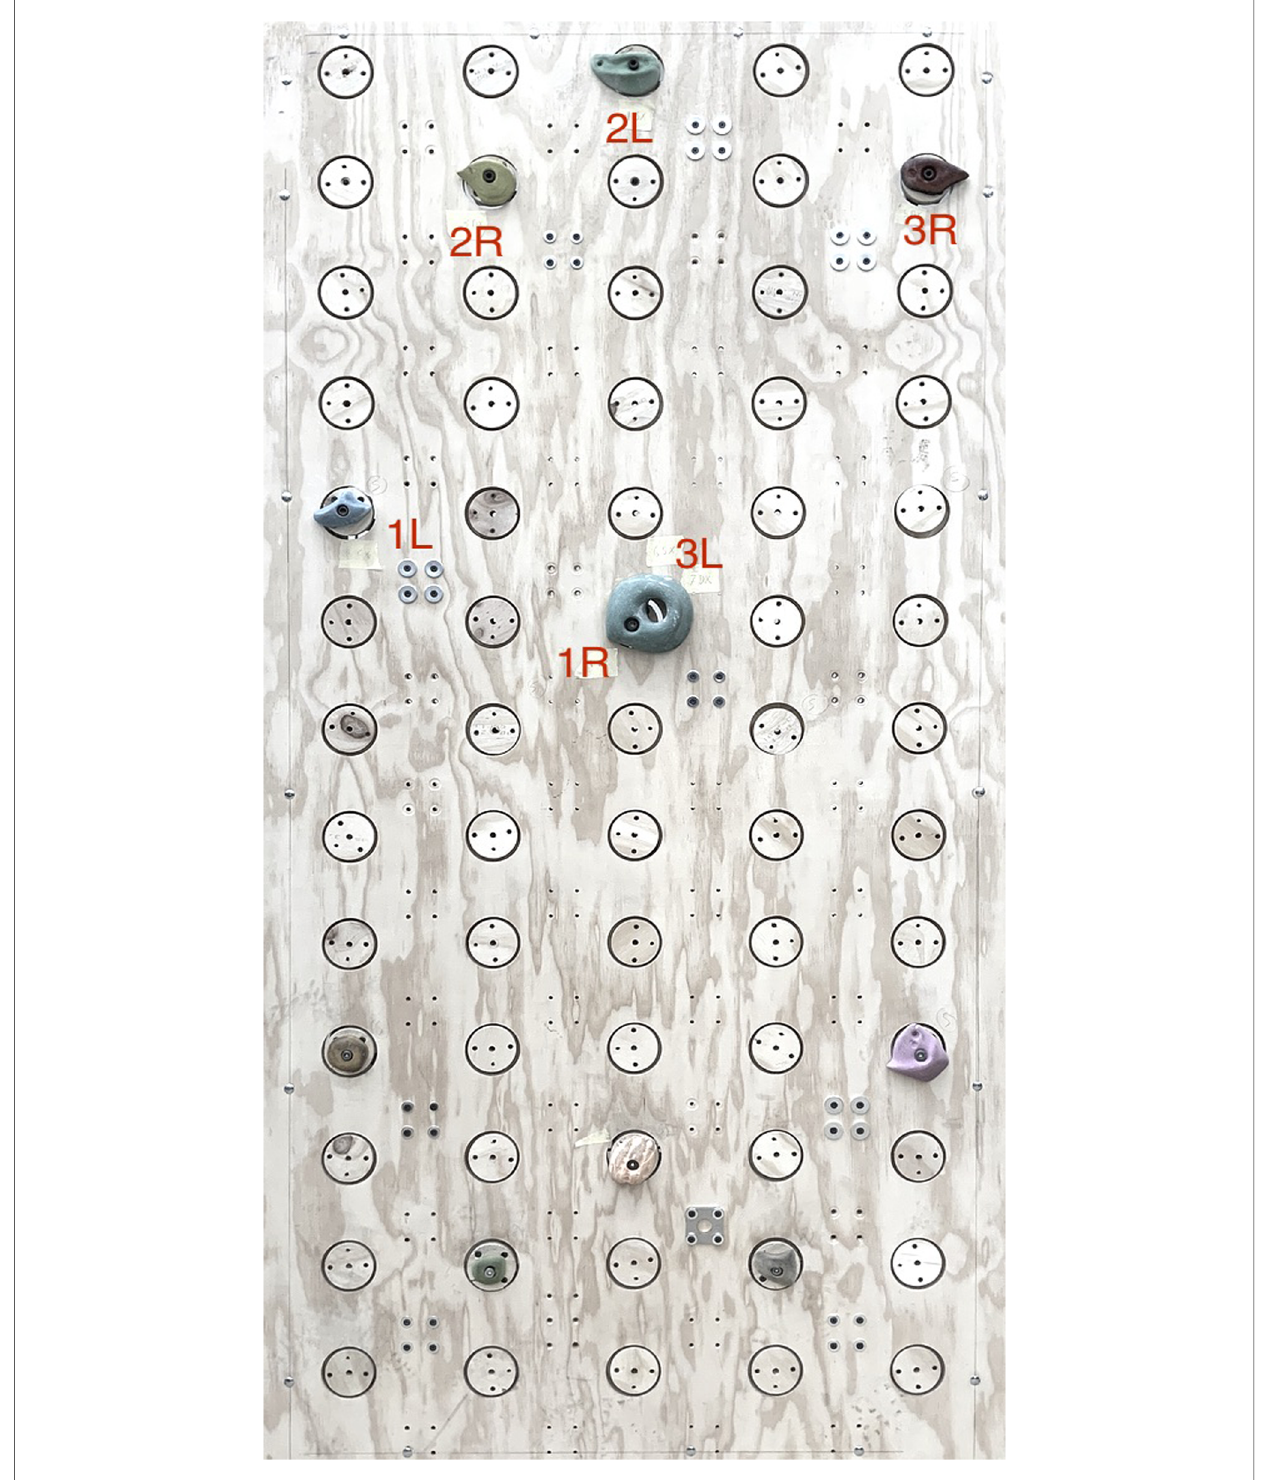
FIGURE 7 Sensorized wall setup. The labels indicate the sequence of mandatory hand moves that was used in the test, as described in the Sensor network validation